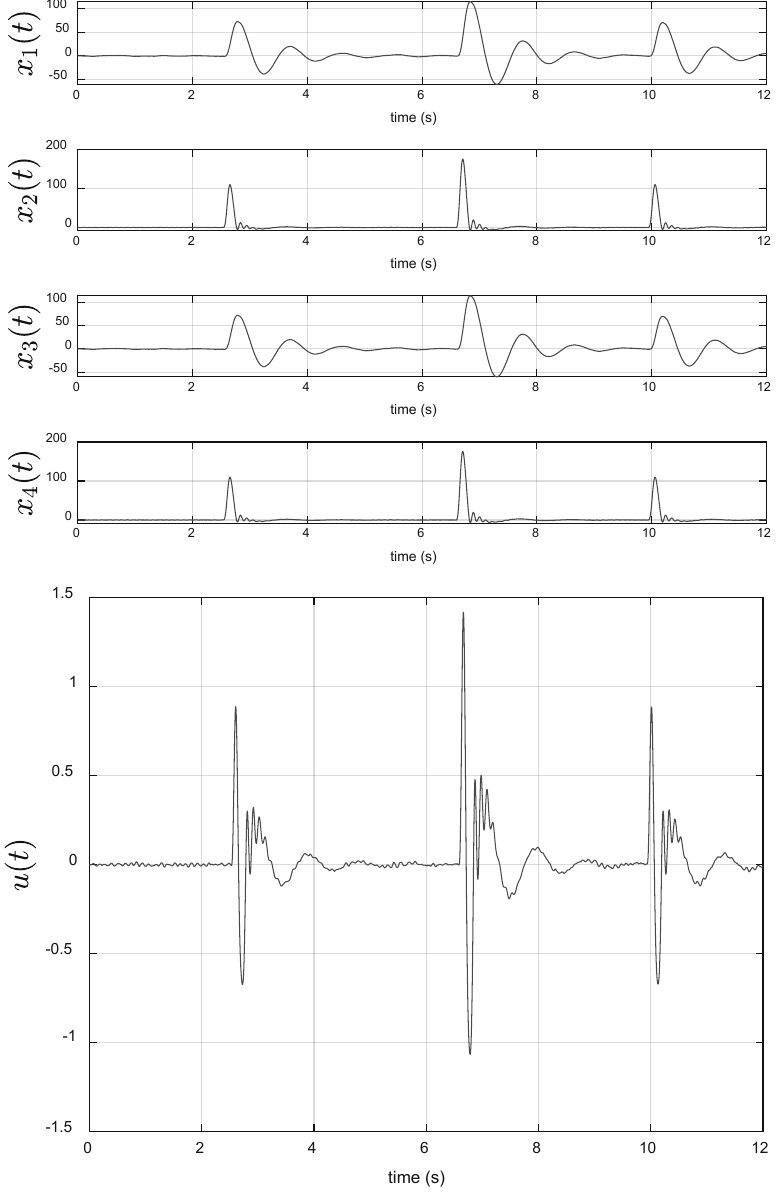
Figure 8. Asymptotic behavior of the state of the dynamic system ( top ) and optimal control ( bottom